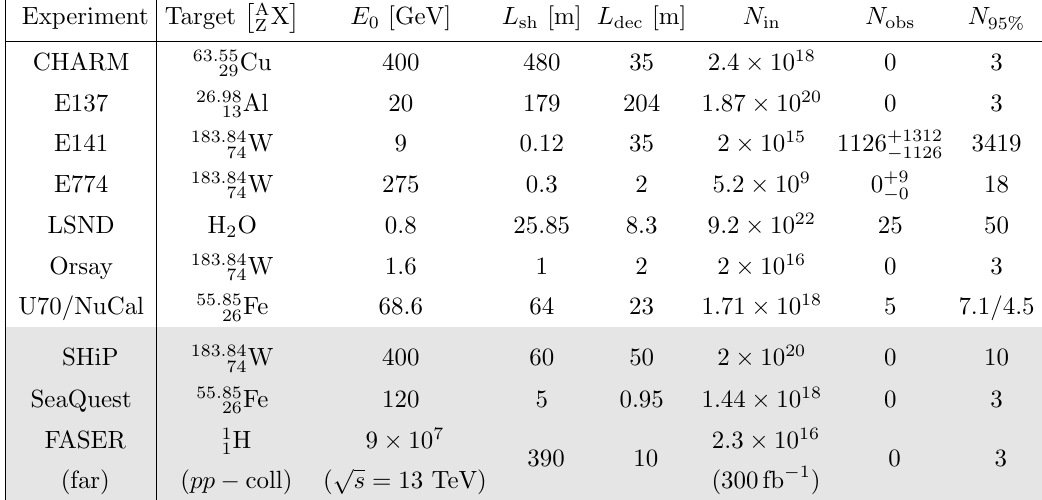
Table 1 . Material constants and speci(cid:12)cations for the di(cid:11)erent beam dump experiments looking for very displaced vertices. Future experiments are indicated by grey